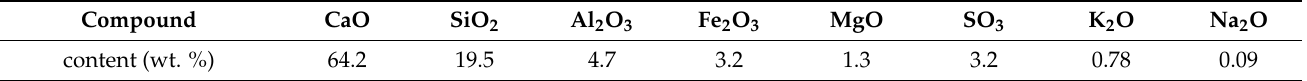
Table 1. Cement composition guaranteed by producer (CEM I 42.5 R). Compound CaO content (wt. %)